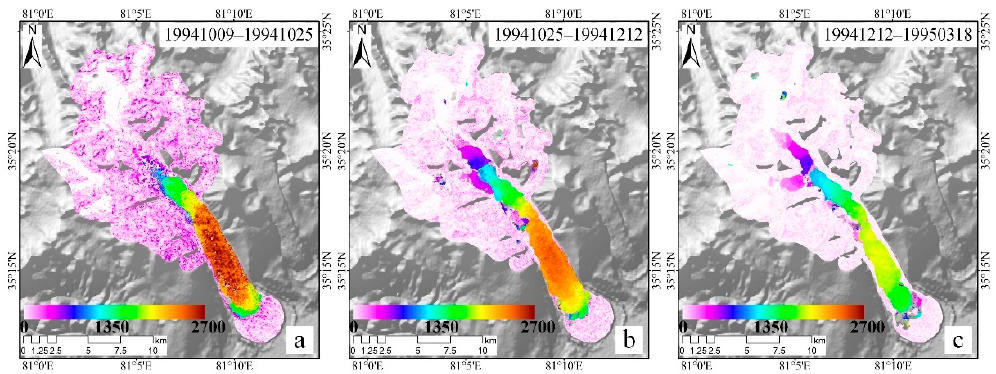
Figure 3. Flow velocities (m yr − 1 ) of the Chongce Glacier during the periods of 16 February 1990–19